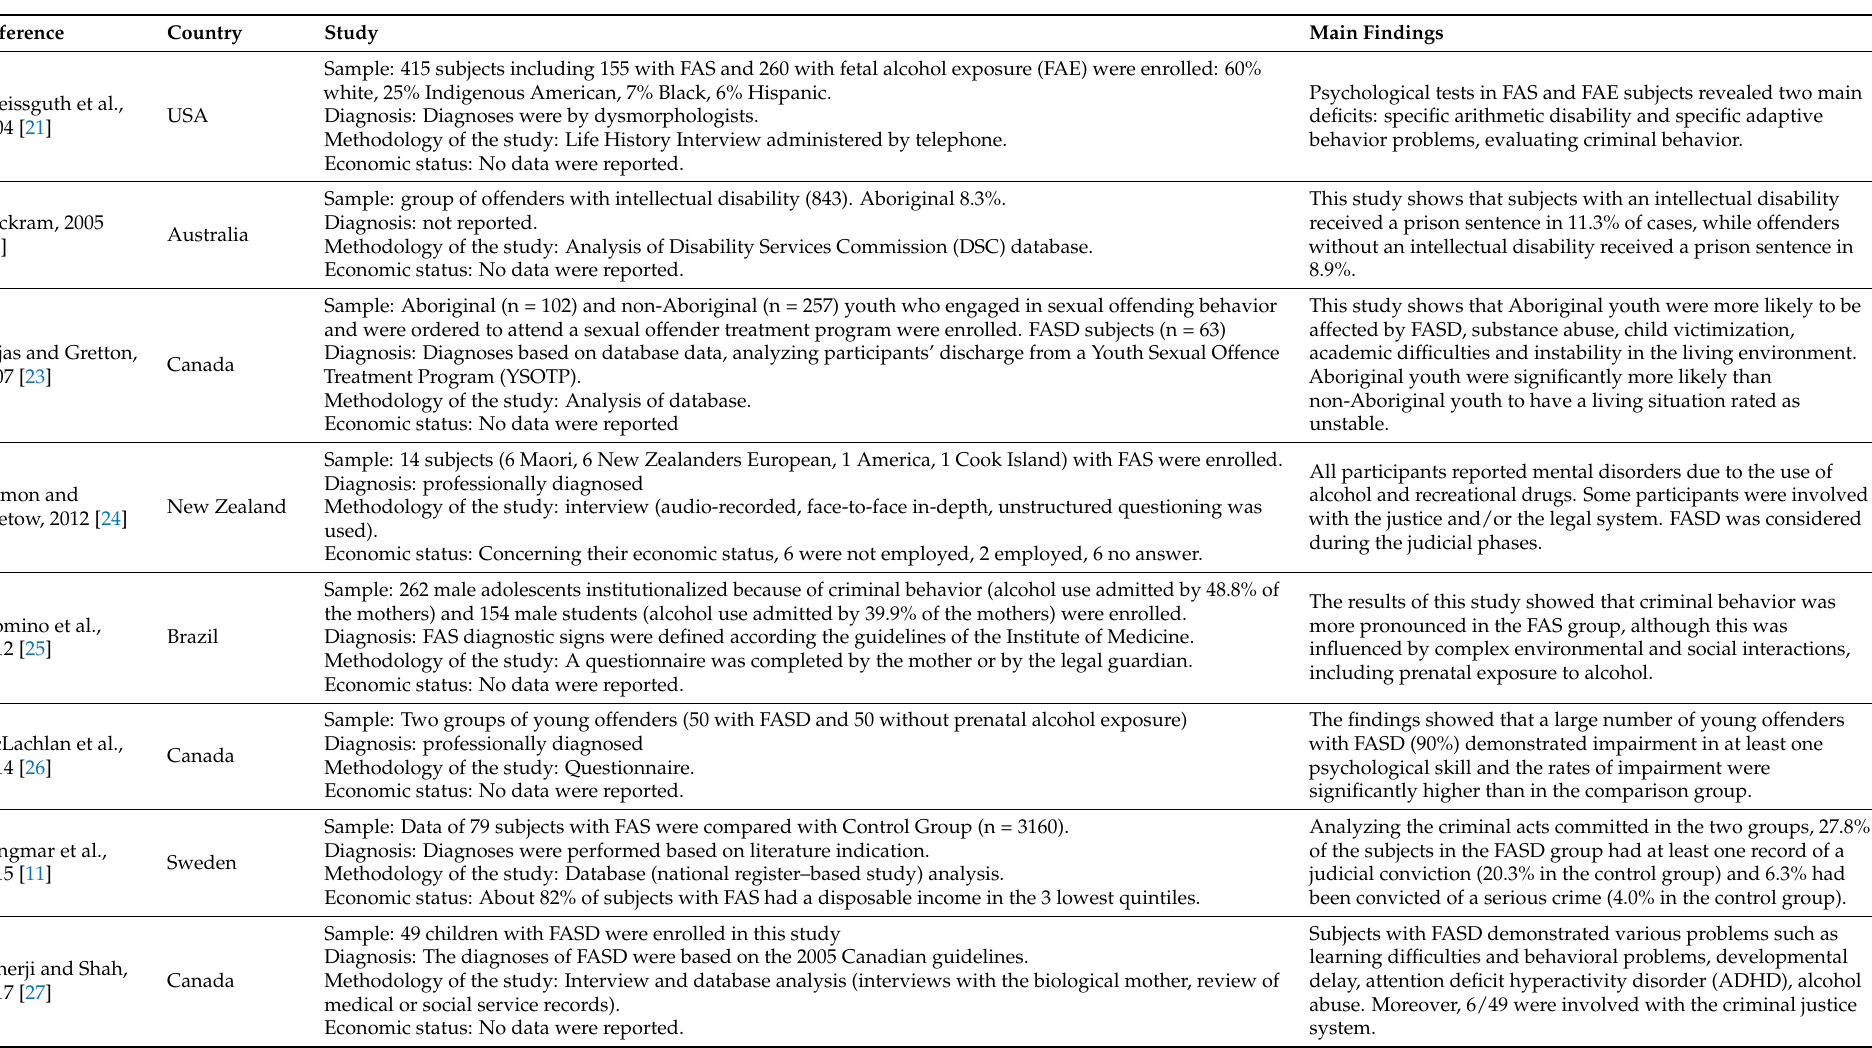
Table 1. Summary of the details of the systematic